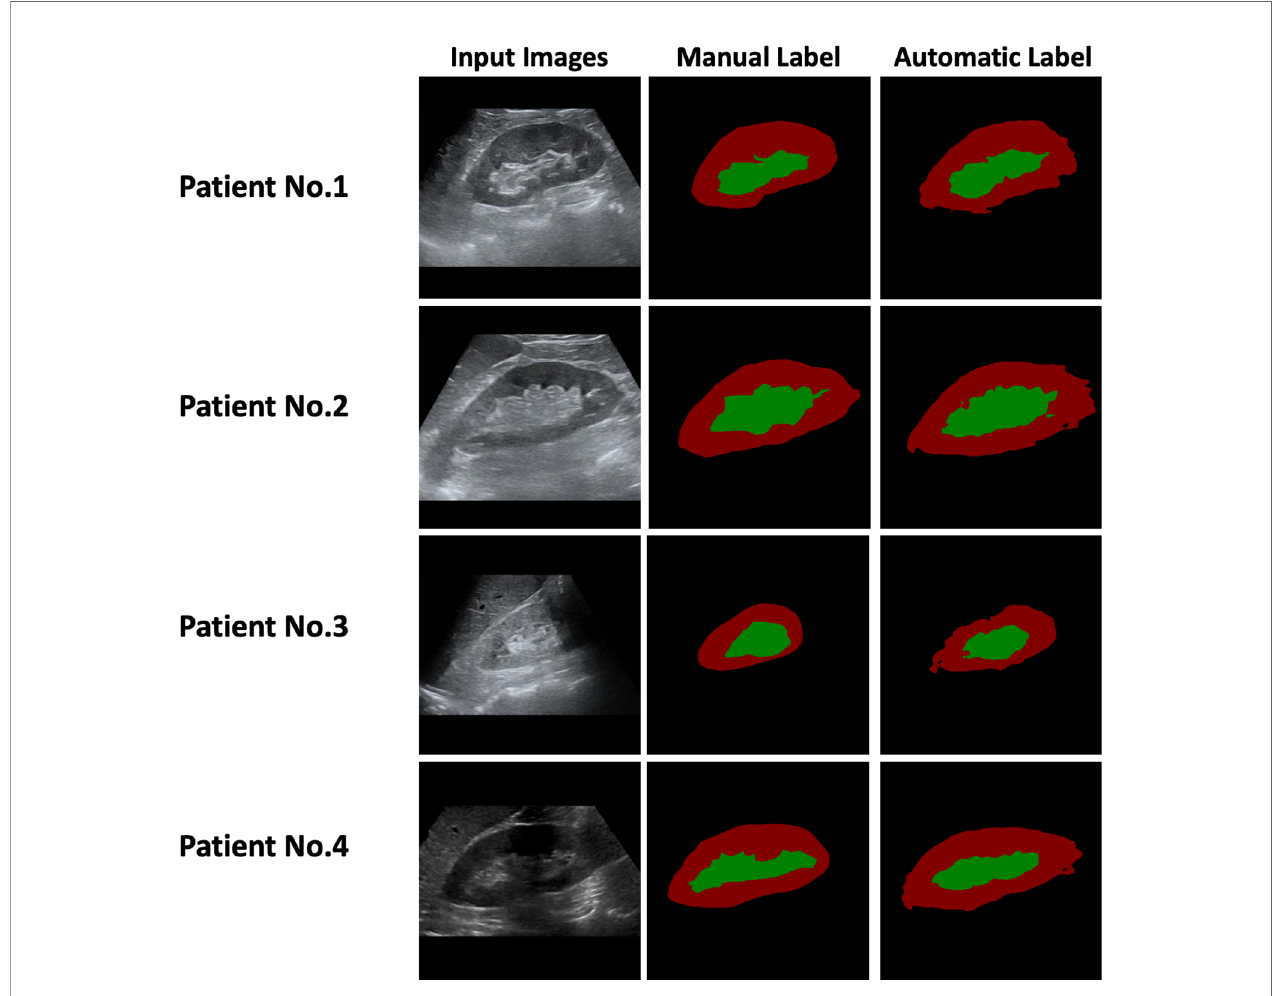
FIGURE 2 | Manual and Automatic Segmentation using Ultrasound Images of the